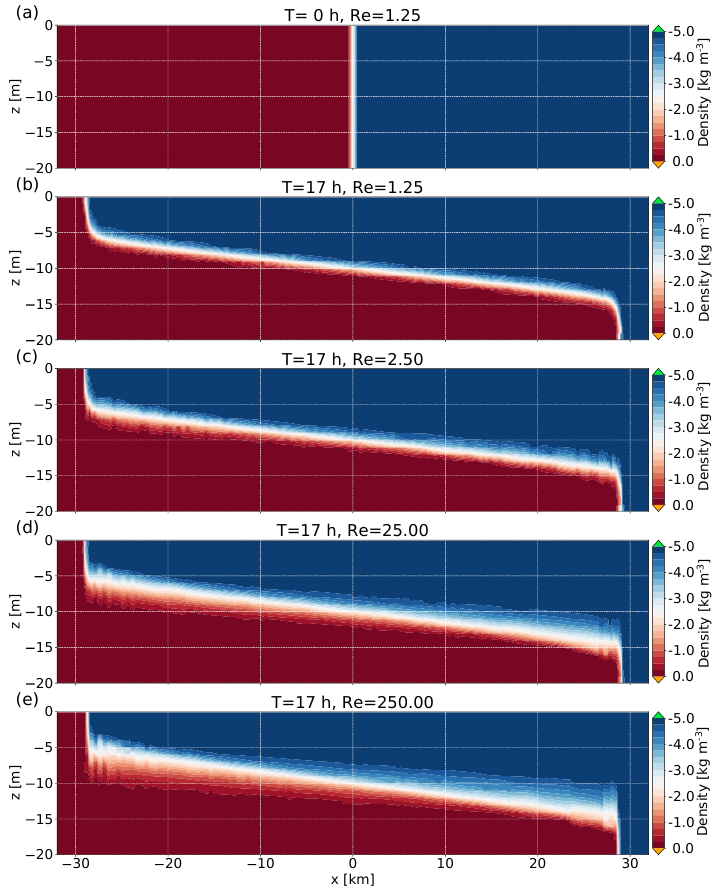
0km). (a) Initial condition. Solution after 17h of =